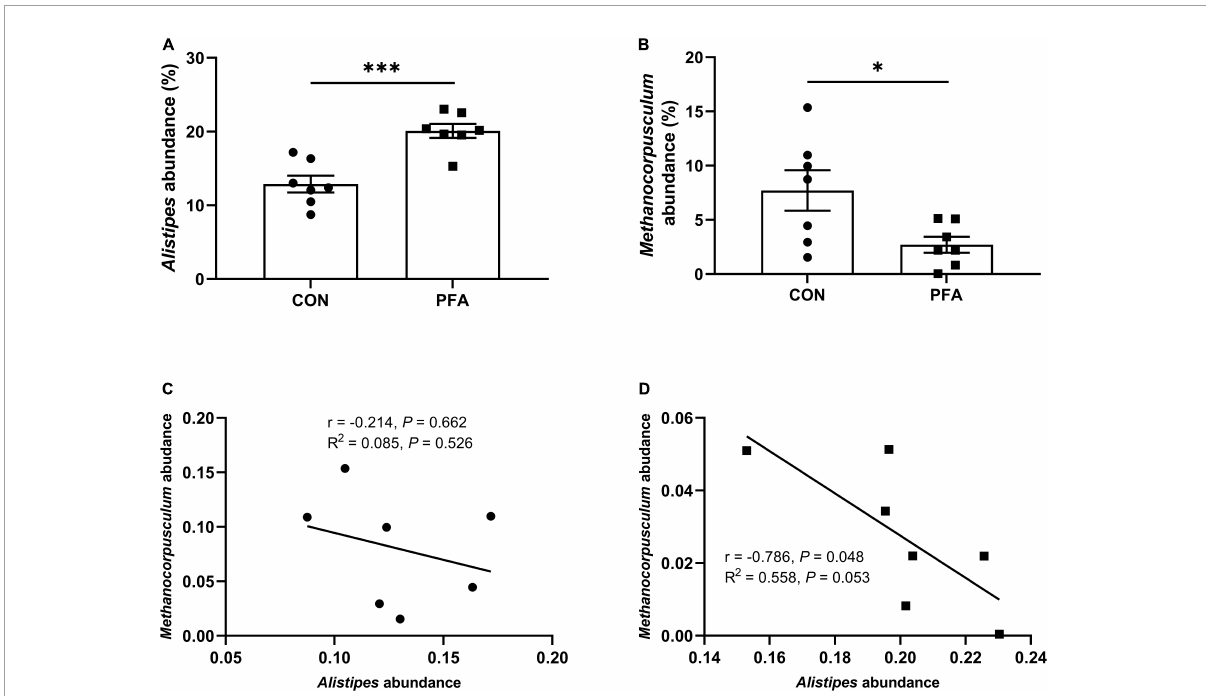
FIGURE5 Relative abundance of cecal microbiota (at the genus level) that are significantly different between two treatments in broilers. (A,B) Relative abundances of Alistipes and Methanocorpusculum . Differences between treatments were displayed by ∗ P < 0.05 and ∗∗∗ P < 0.001. Values are mean ± standard error. (C,D) The correlation between the Alistipes and Methanocorpusculum abundances for CON group and PFA group based on Spearman’s correlation test and simple linear regression analysis. Statistical significance was set at P < 0.05. CON, broiler chickens fed basal diet; PFA, broiler chickens fed basal diet supplemented with 1,000 mg/kg paraformic acid, n =